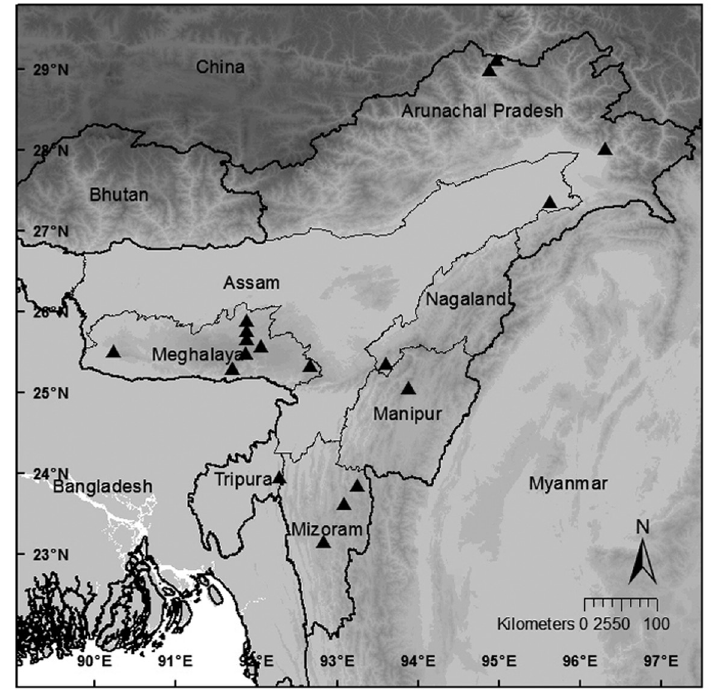
Fig. 52. Map showing the location of B. roxburghii (Miq.) A.DC.